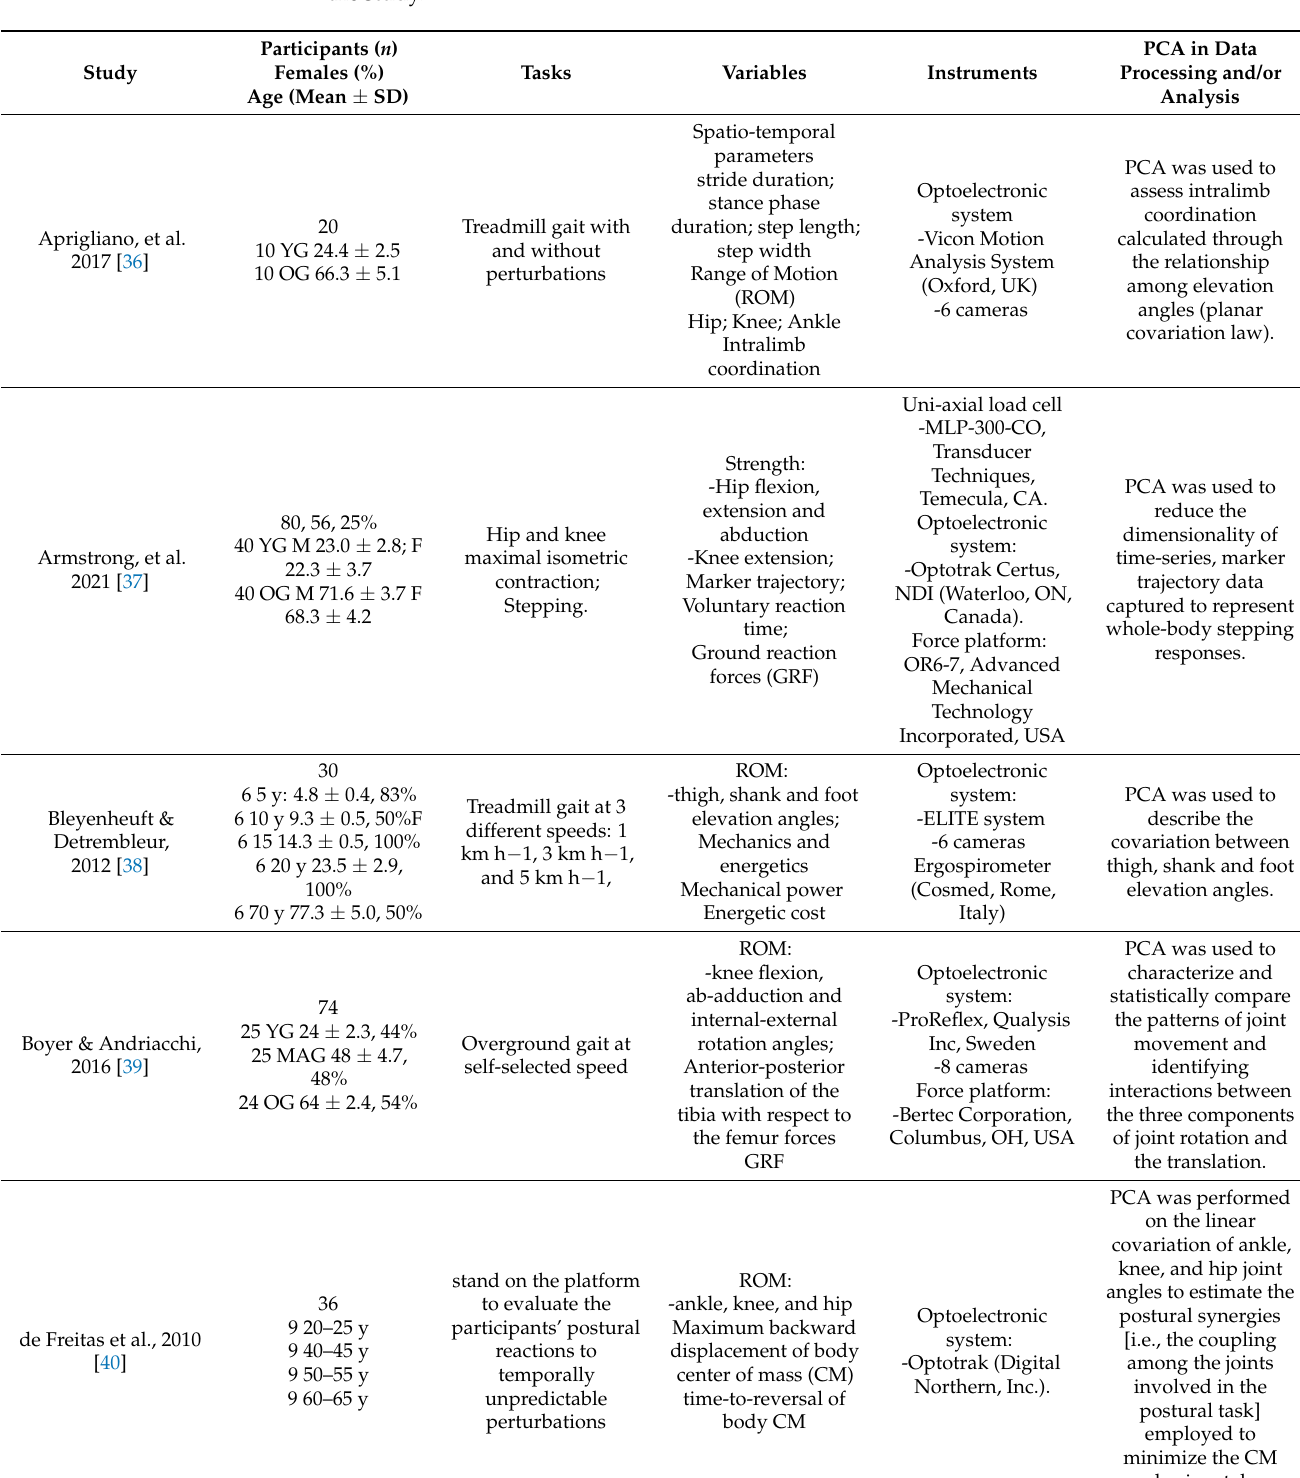
Table 3. Included studies’ characterization, specifically, the study identification, sample size, mean age, and percentage of females, the tasks, variables, instruments and description of the PCA use in the